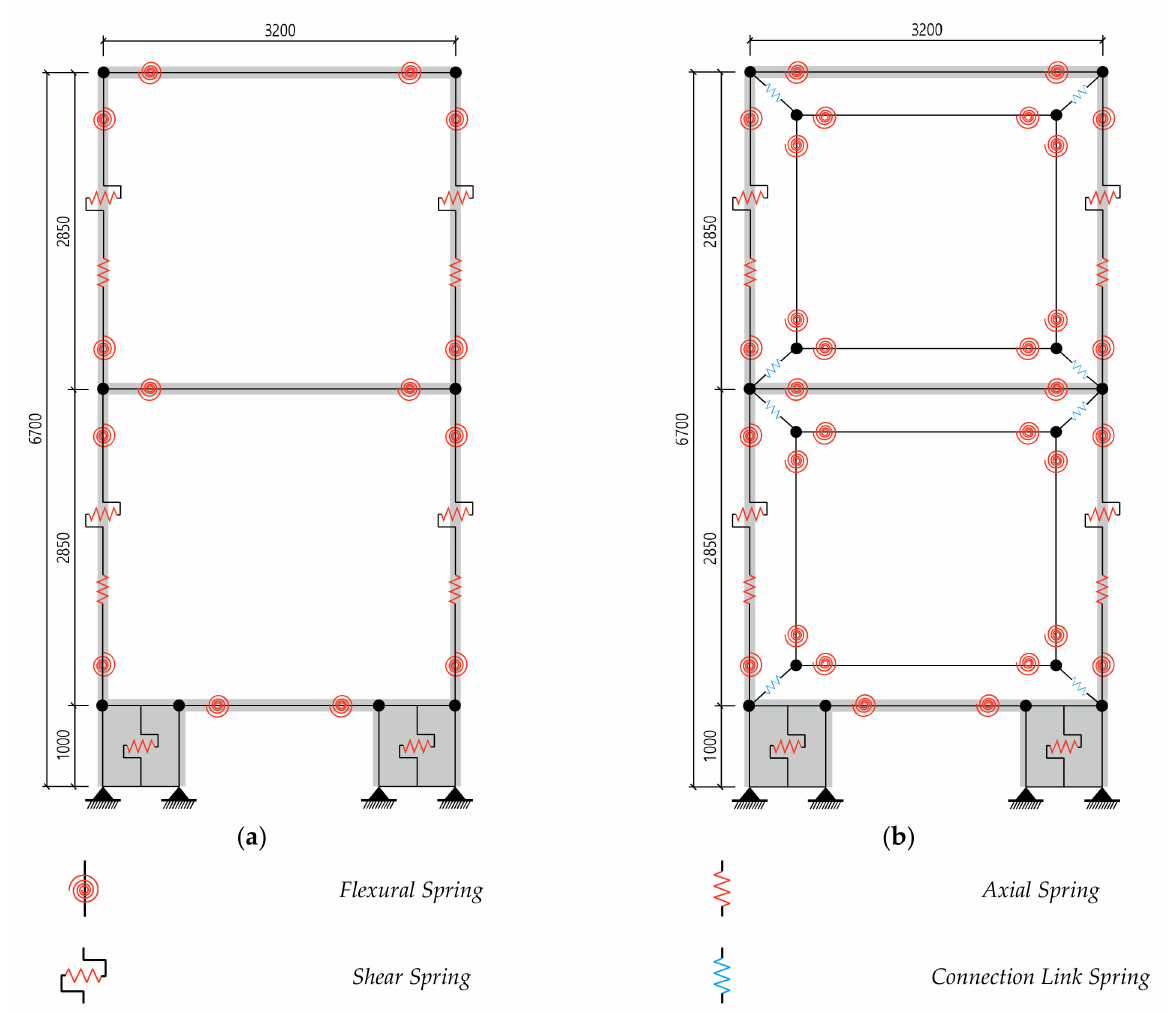
Figure 20. Non-linear dynamic analysis models: ( a ) control specimen (PD-FR); ( b )